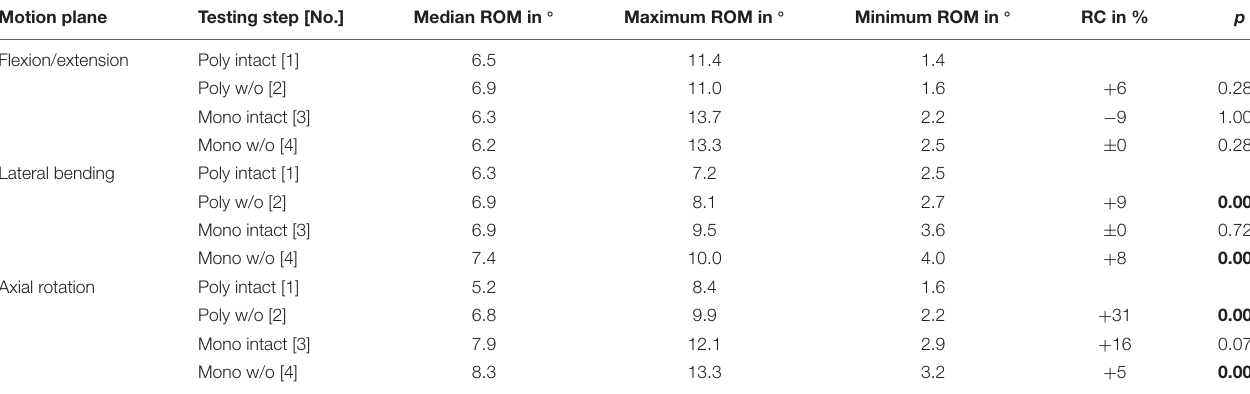
TABLE 4 | Results for T1-T2 range of motion at pure moments of ± 5 Nm ( n = 8) depending on primary motion plane and testing step. Motion plane Testing step [No.] Median ROM in ◦ Maximum ROM in ◦ Minimum ROM in ◦ RC in %